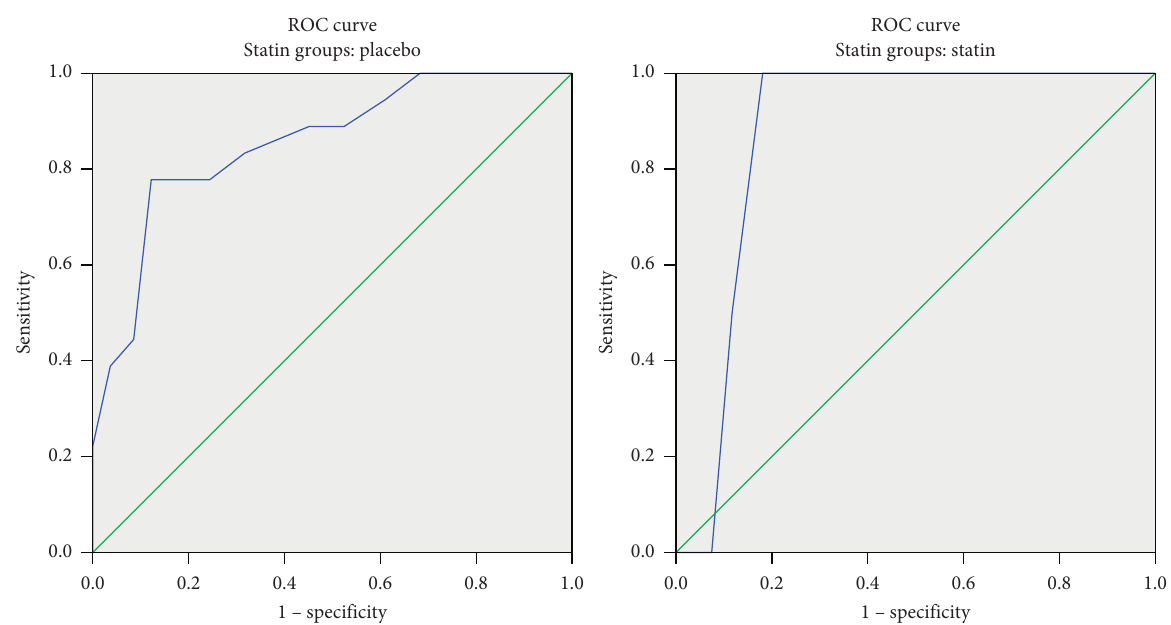
Figure 2: AUC regarding volume of contrast